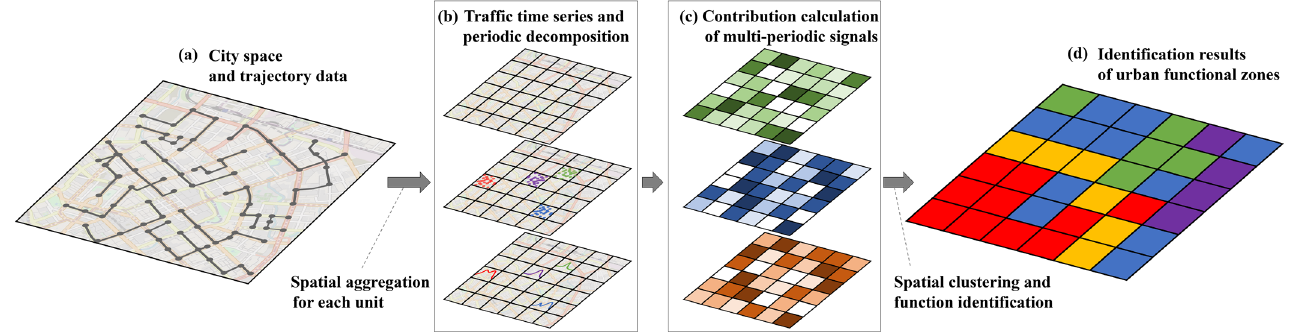
Figure 1. Illustration of the scenario being studied in this paper. ( a ) the example of the city space and trajectory data, ( b ) the traffic time series and periodic decomposition, ( c ) the calculation of the contribution of multi ‐ periodic signals, and ( d ) the identification results of urban functional zones.